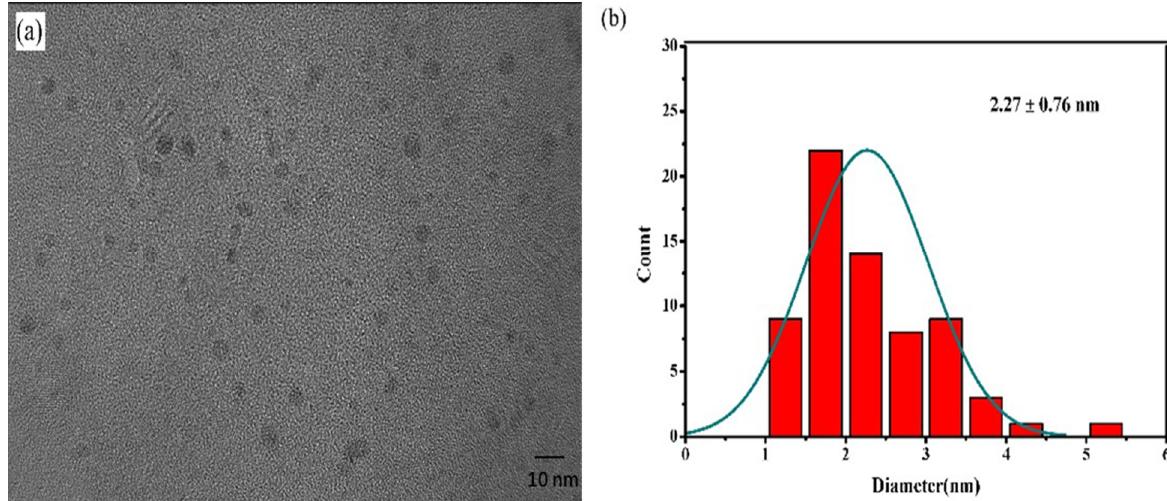
Figure 1. Morphological characterizations of the SQDs: ( a ) TEM images; ( b ) size distribution histogram.